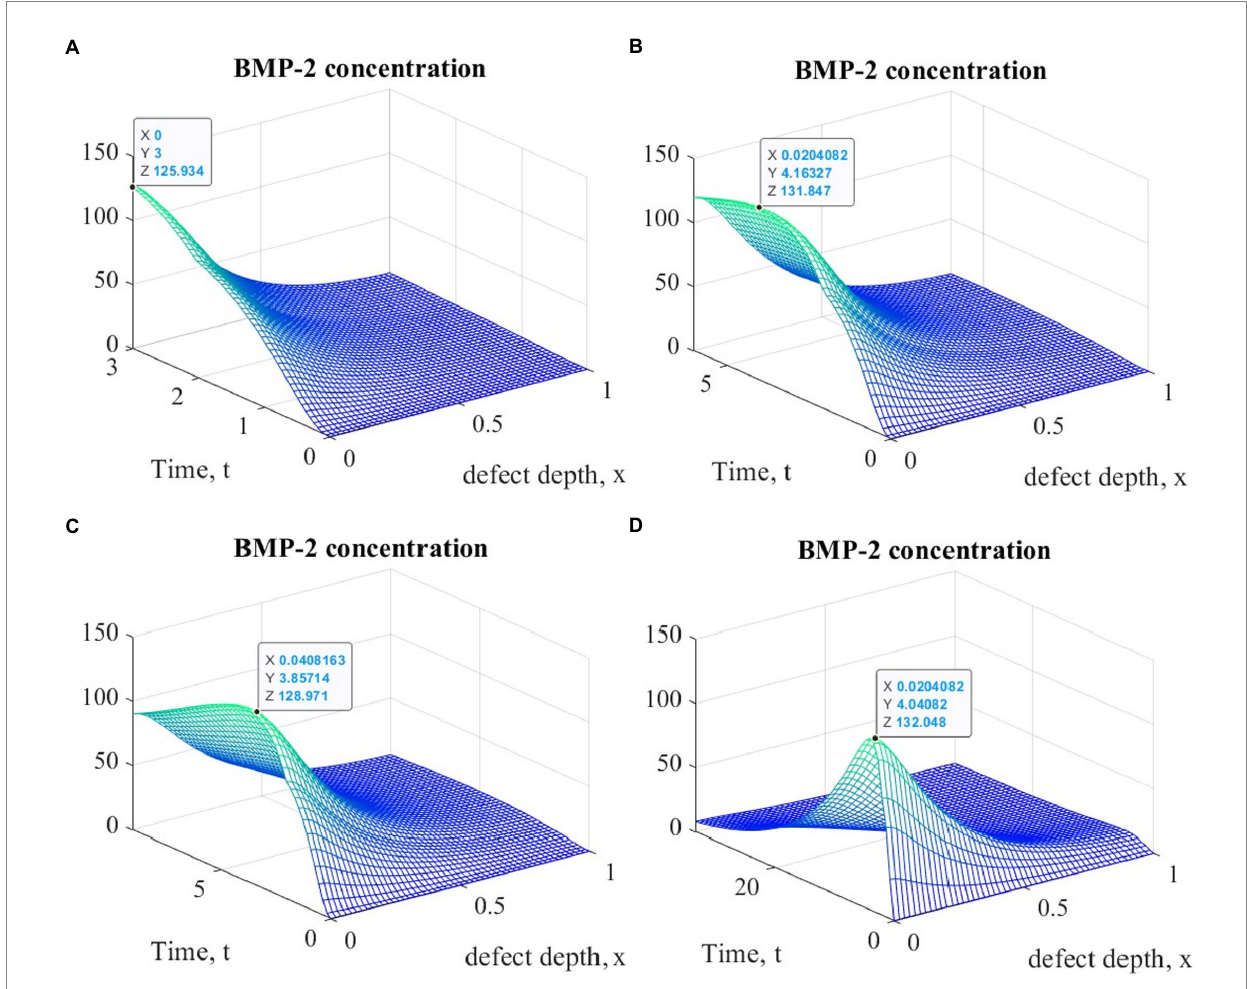
FIGURE 5 Graphs of changes in BMP-2 concentration at different points in time during the implementation of ACIT with mechanical stimulation with a time delay